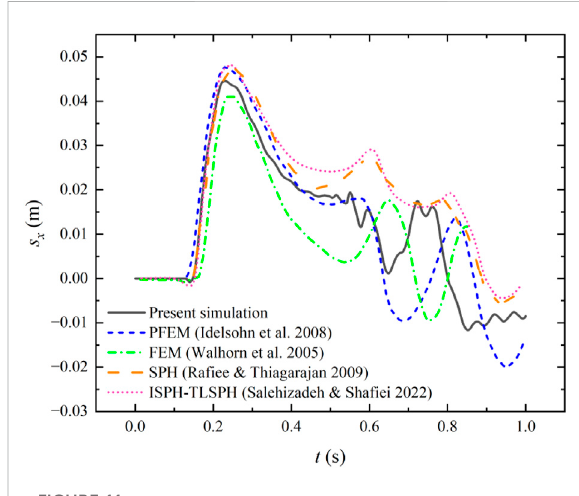
The time history of horizontal displacement of the upper left corner of the elastic baf fl